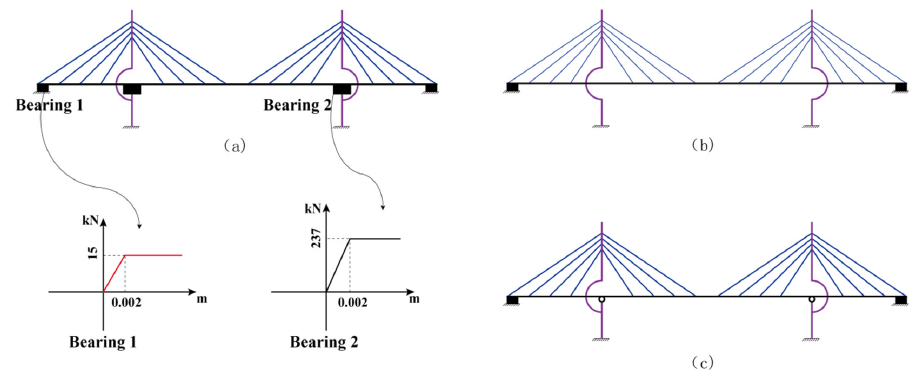
Figure 5. Schematic models of different deck to pylon connections; ( a ) Connection 1—connected by bearings in longitudinal direction; ( b ) Connection 2—not restrained in longitudinal direction; ( c ) Connection 3—restrained in longitudinal direction.